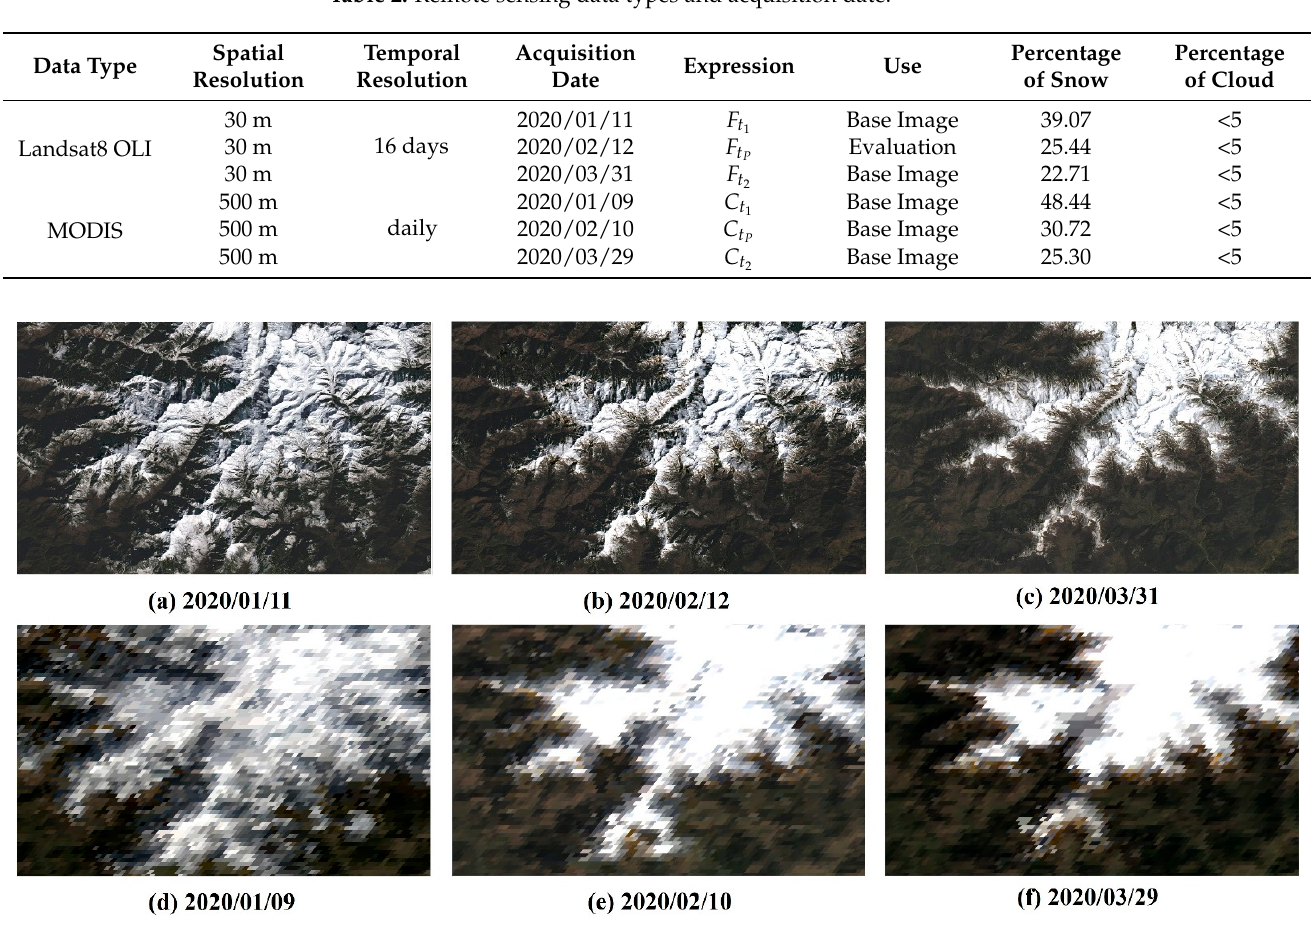
Table 2. Remote sensing data types and acquisition date.